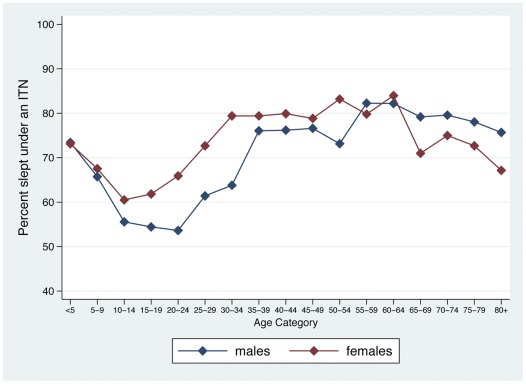
Among all household members, percent who slept under an ITN the night before the survey, by five-year age category and gender, Sierra Leone, 2011.